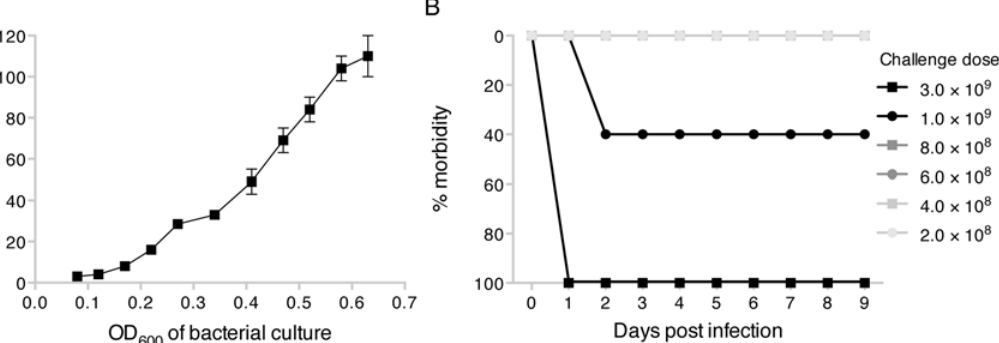
Fig 2. Determination of bacterial challenge dose. (A) The association between the OD 600 of the bacterial culture and the number of CFUs/ μ l was determined for Pseudomonas aeruginosa by plating dilutions of bacterial culture and quantitating colonies. The OD 600 quantitation of CFU/ μ l was then used to determine the numbers of CFUs in the bacterial culture in real time. (B) The amount of bacteria that untreated C3H/HeN mice could control was determined by challenging with increasing amounts of CFUs intraperitoneally and following for morbidity as defined in Table